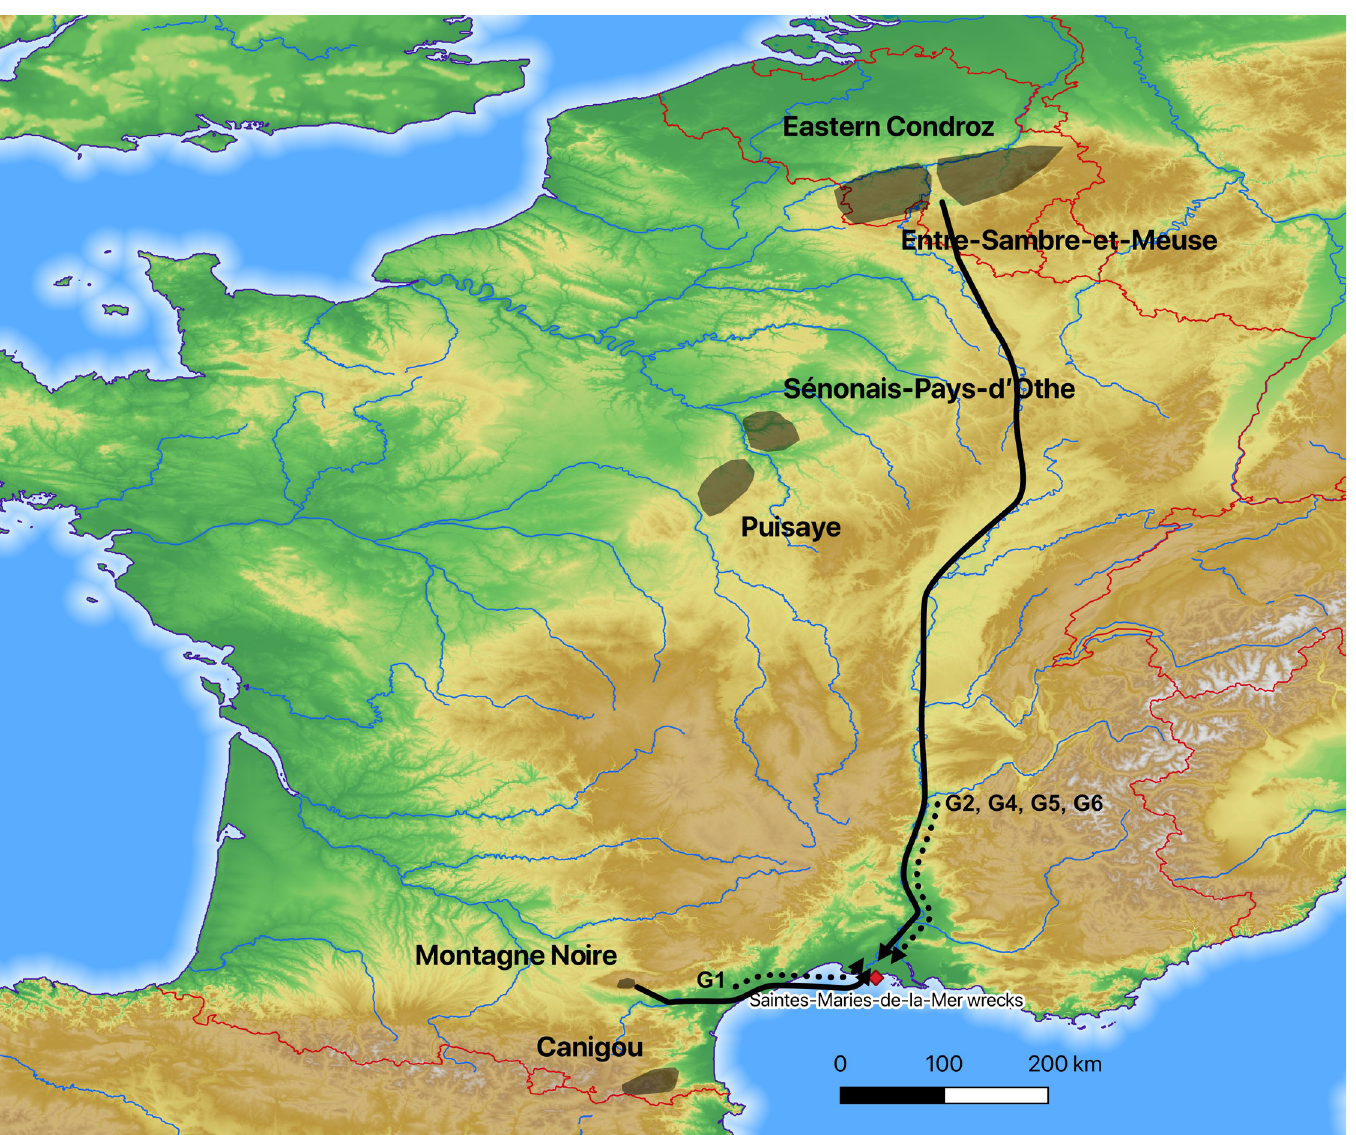
Fig 26. Direction and route of traffic from identified (solid line) and uncertain (dashed black line) provenance groups; as we have no identified provenance for wreck SM24, groups GP, G1a and G3 are not mentioned on this map (north at the top; DEM NASA Shuttle Radar Topography Mission Global 1 arc